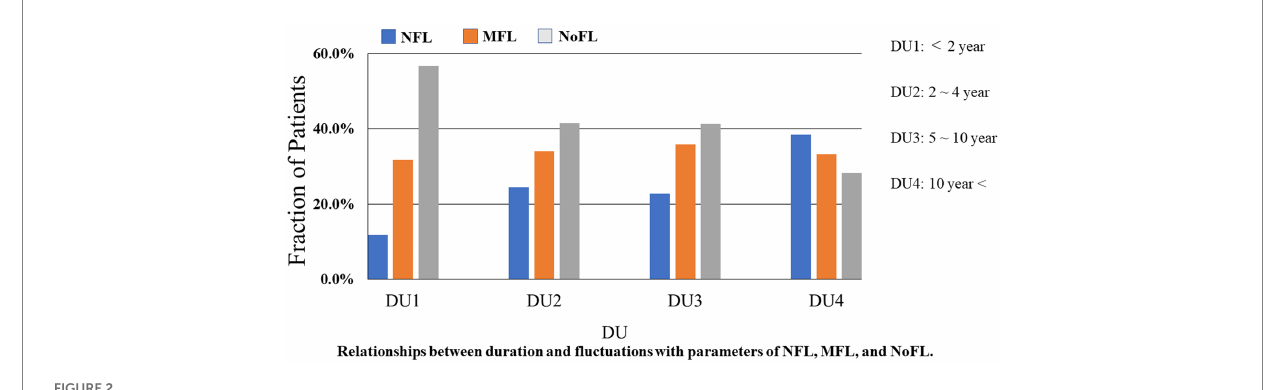
FIGURE 2 Relationship between duration and fluctuations.